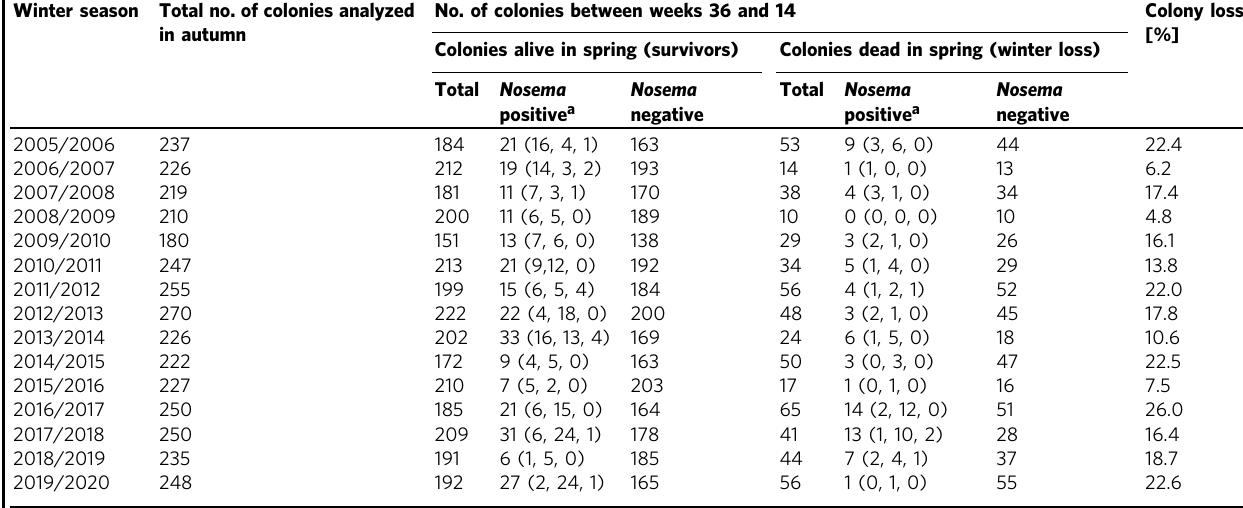
Table 3 Data on Nosema spp. epidemiology (prevalence of Nosema spp.-, N. apis -, N. ceranae - and co-infections) and winter losses collected between autumn 2005 and spring